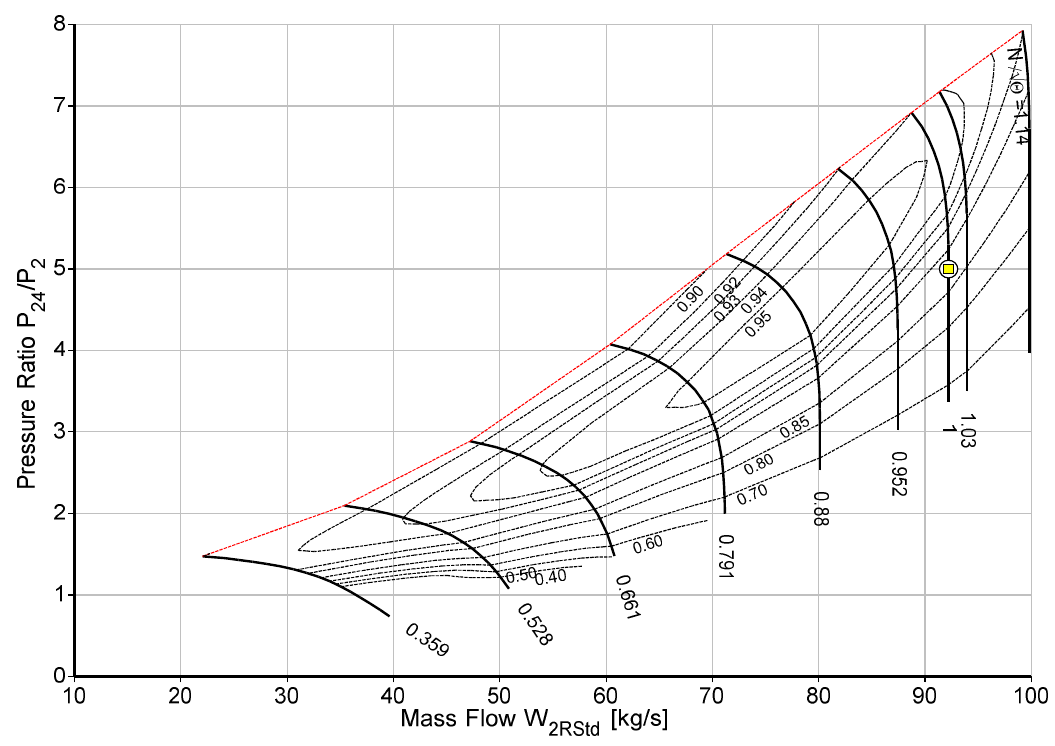
Figure 2. Booster/low-pressure compressor scaled map. Table 1. RB211-24G engine design point model input data (sources: datasheet and [44]).